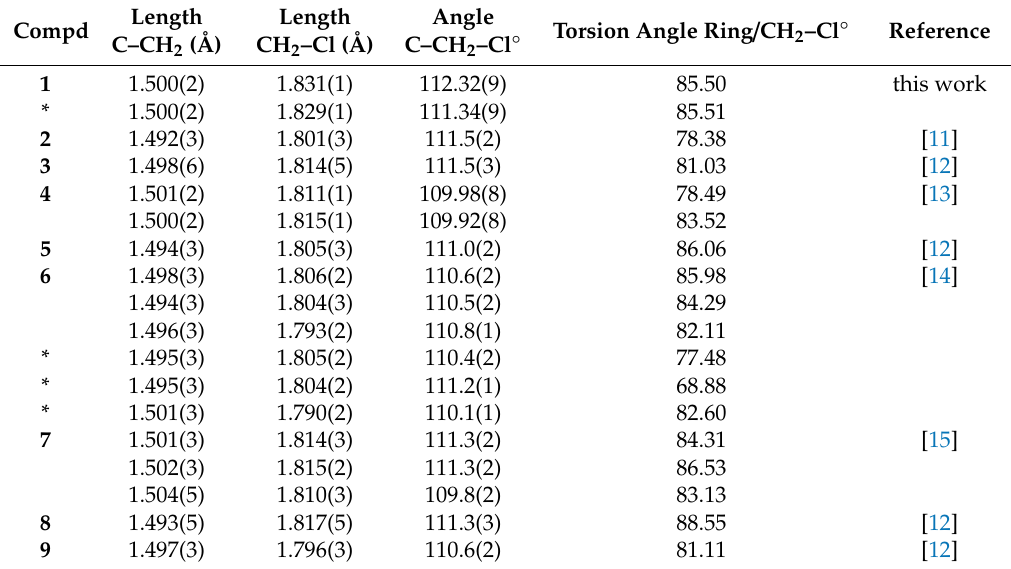
Table 1. Key geometric parameters for crystallographically characterised benzyl